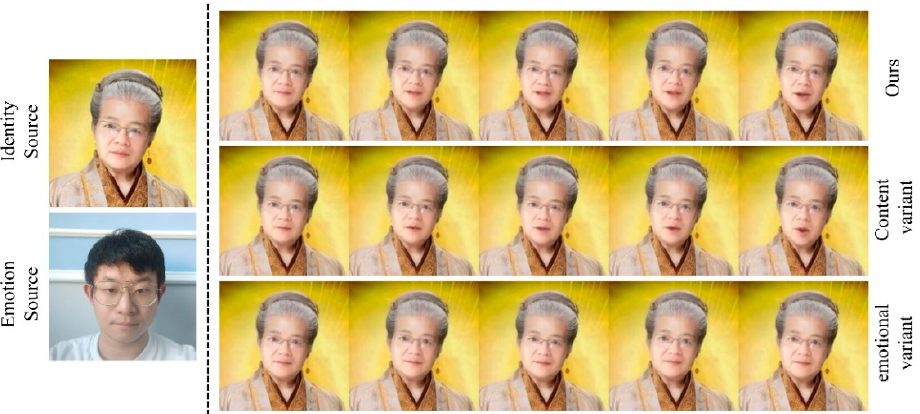
Figure 5. A comparison of our approach with different variants: our full model ( top right ), the content variant ( middle right ), and the affective variant ( bottom right ).